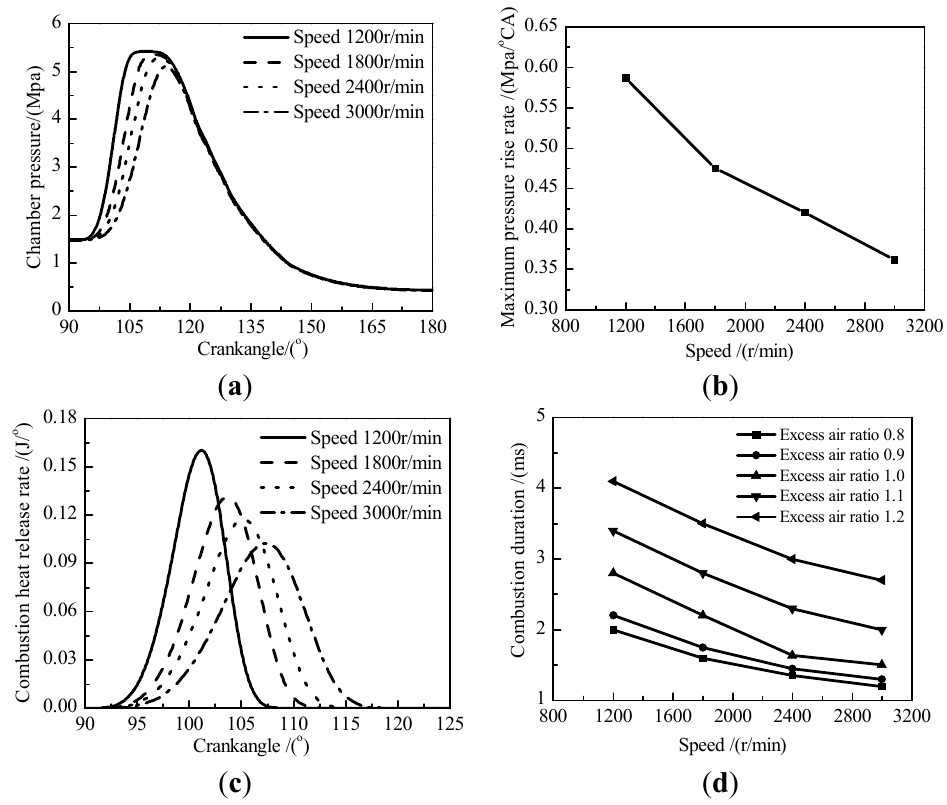
Figure 7. ( a ) Chamber pressure for different speed; ( b ) Maximum pressure rise rate for speed. ( c ) Combustion heat release rate for different speed; ( d ) Combustion duration for different excess air ratio and